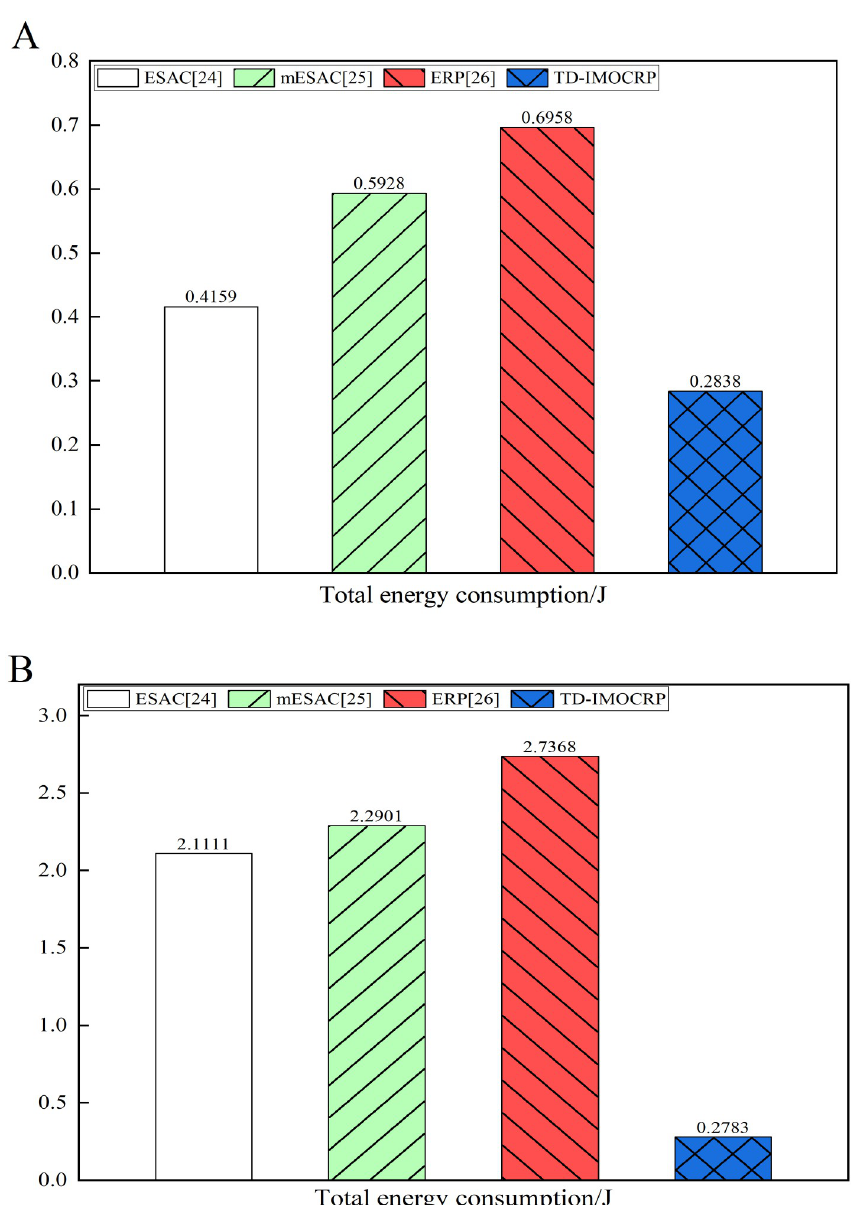
Fig 11. Comparison results of total energy consumption. (A) The sink is located at the center. (B) The sink is located at (0,0).